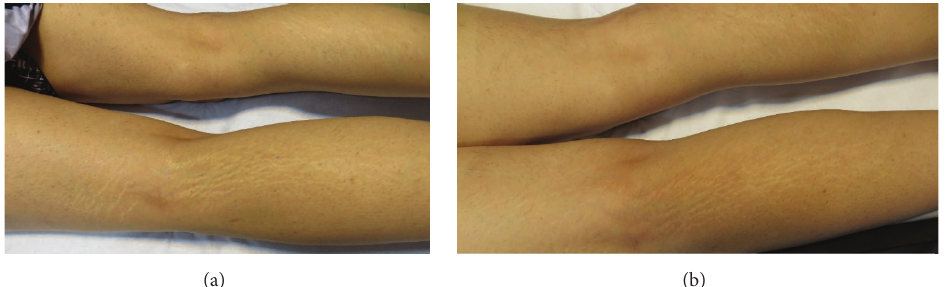
Figure 5: Improvement in clinical appearance of striae alba. Baseline (a) and posttreatment (b) with fractionated microneedle radiofrequency combined with fractional carbon dioxide laser.